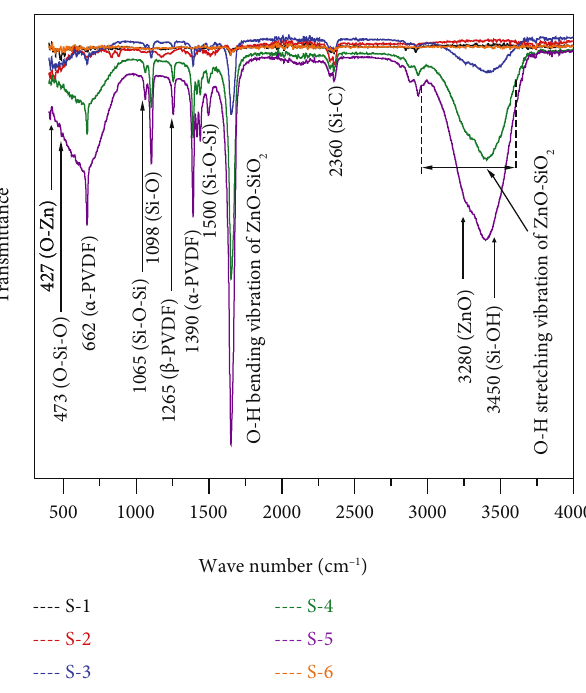
Figure 6: FTIR spectra of PVDF and PVDF-based NC